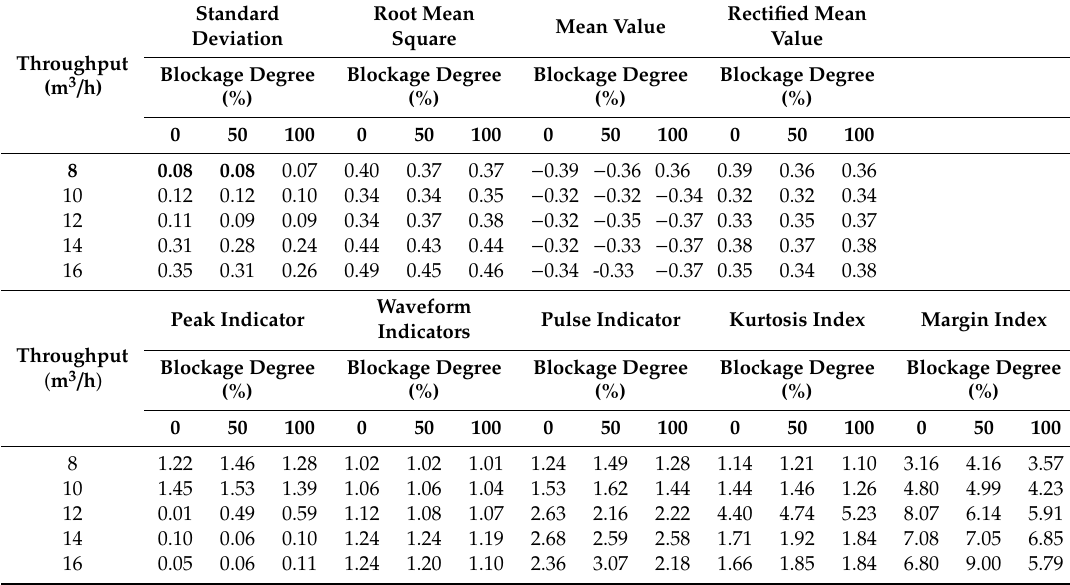
Table 4. Dimensional and non-dimensional